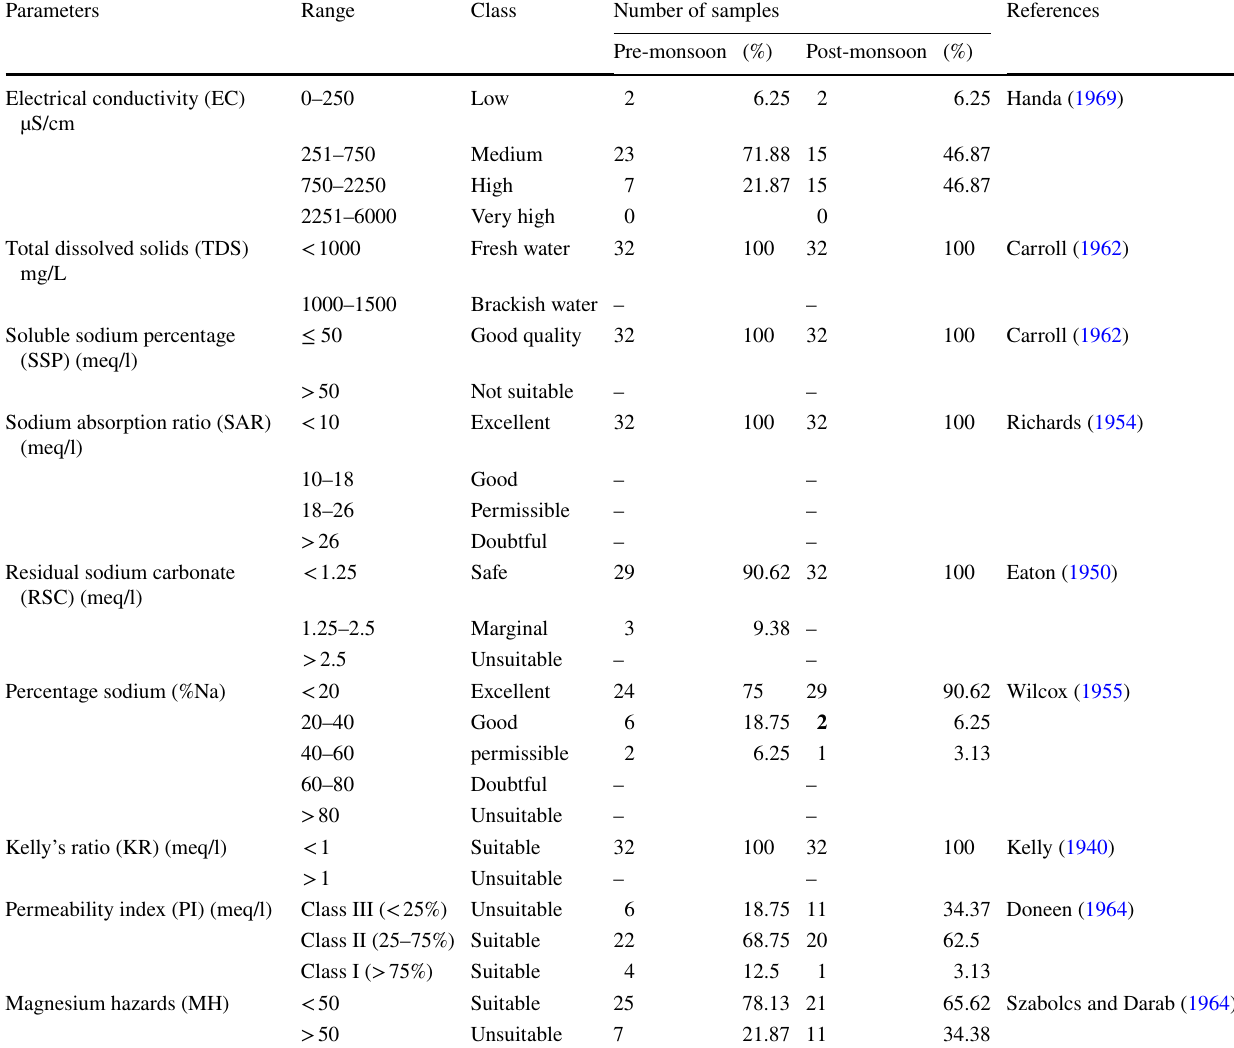
Table 4 Classification of groundwater based on irrigational water quality parameters